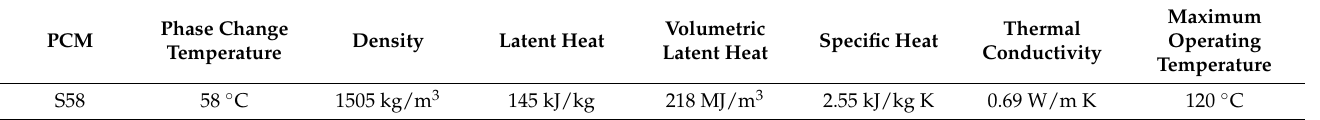
Table 1. Nominal features of the PCM S58